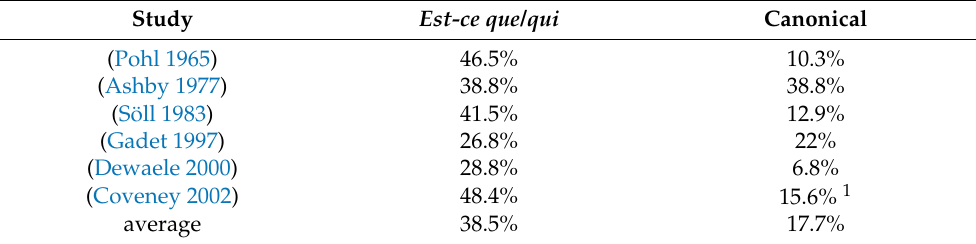
Table 1. Frequencies of partial interrogative variants in spoken